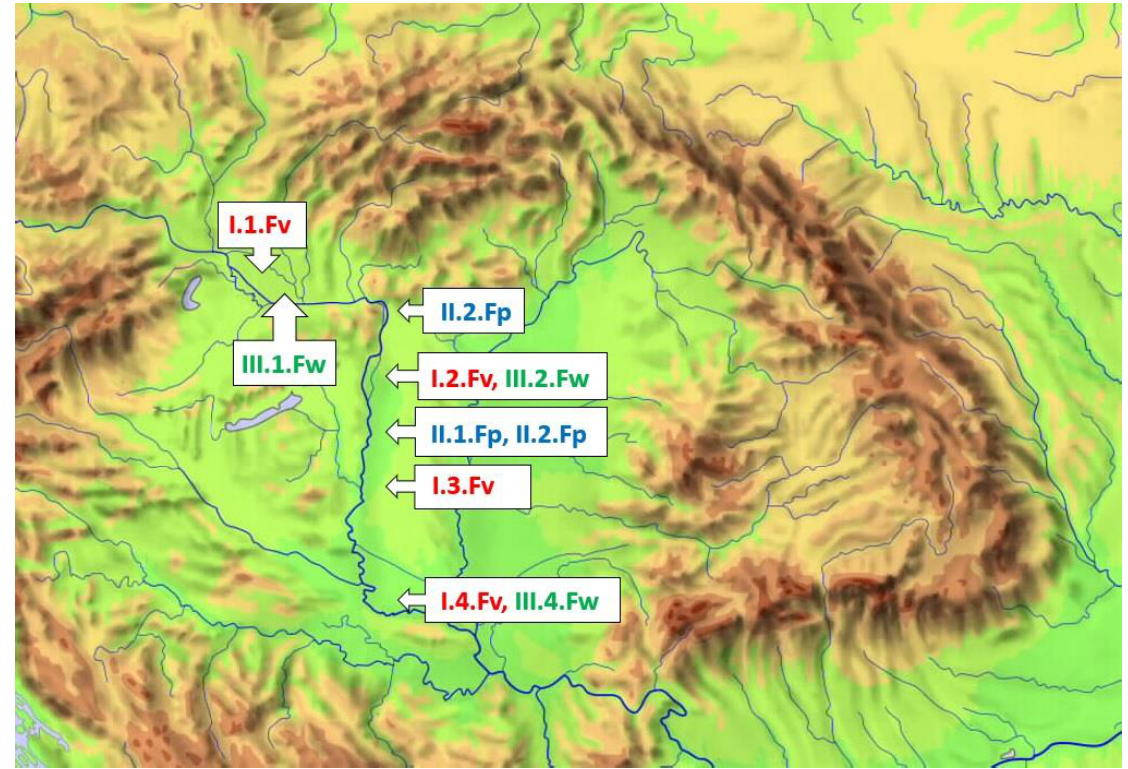
Figure 1. Location of the sample areas.